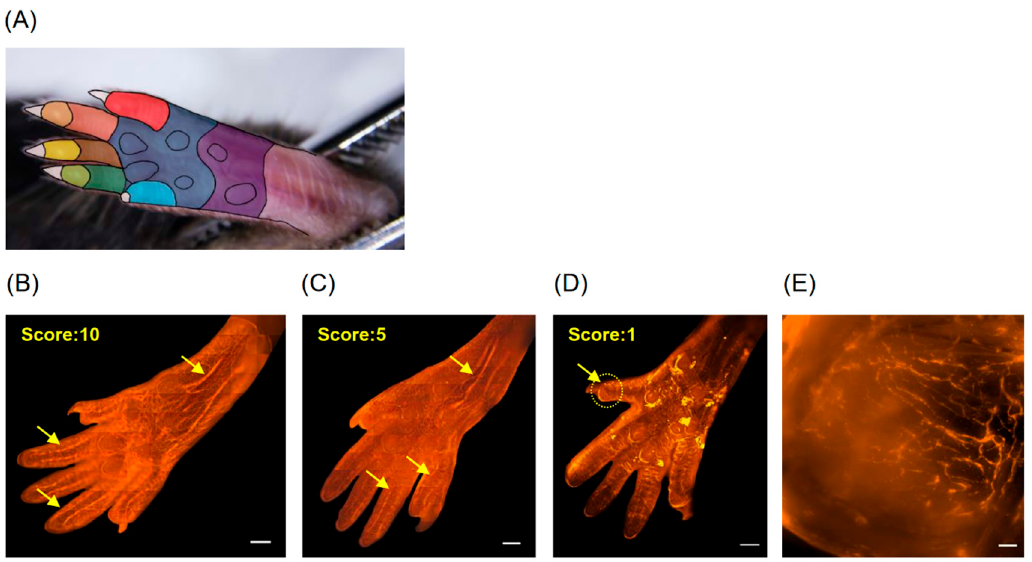
Figure 1. Scoring of chronic constriction injury (CCI)-induced nerve injury in the hind paw. Nav1.8-tdTomato nerve fibers were observed using a fluorescent microscope. ( A ) The underside of the hind paw was divided into 10 regions (eight in the five toes, two in the palm of the paw), as indicated by di ff erent colors. One point was scored for each area that exhibited a high degree of innervation. Examples of ( B ) a healthy hind paw scoring 10 points; ( C ) a moderately injured hind paw scoring 5 points; ( D ) a severely injured hind paw scoring only 1 point. Arrows indicate nerve fibers. ( E ) A higher-magnification view showing the nerve fibers remaining in the regions of interest (ROI) indicated in ( D ). Scale bars: 1000 µ m ( B – D ) or 50 µ m ( E